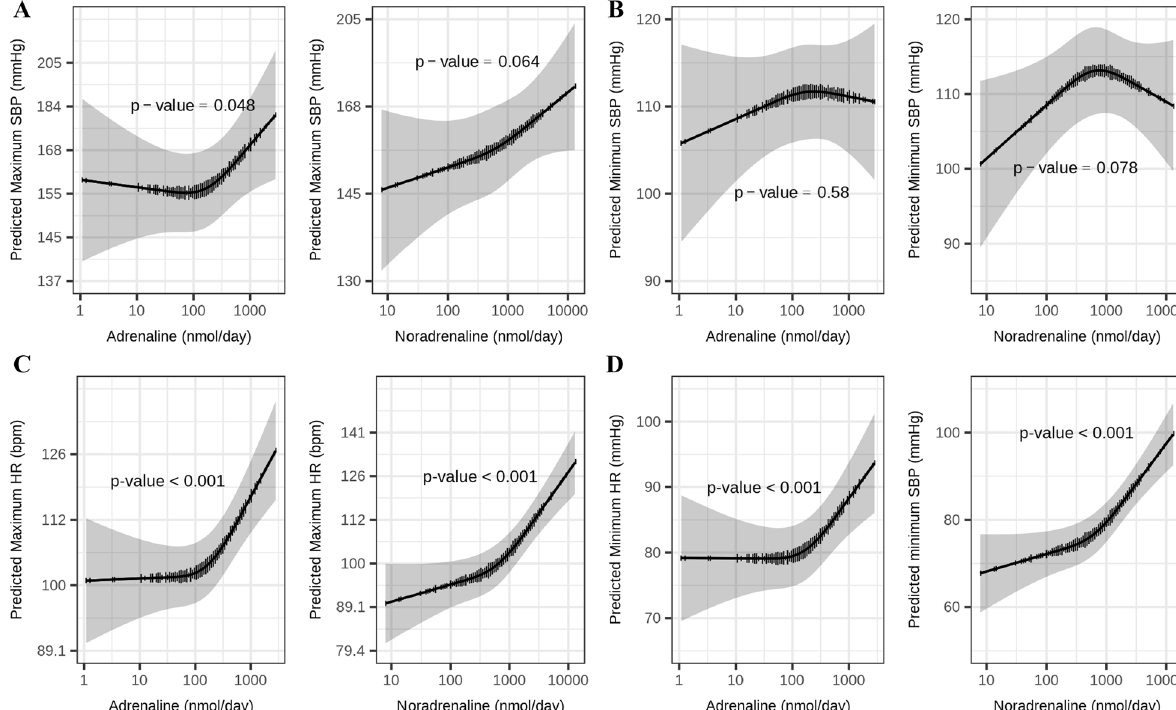
Fig. 1. 24-h urinary catecholamine excretion (nmol/day) and cardiovascular parameters on the 5th day of treatment. A Maximum systolic blood pressure (SBP), B minimum systolic blood pressure, C maximum heart rate (HR), and D minimum heart rate; mmHg millimeter of mercury, bpm beats per minute. The vertical lines represent the frequency counts of outcome variables. P -values indicate evidence for overall relationships between catecholamines and cardiovascular parameters measured from models via restricted cubic splines. All predictions are shown for age 48 years, male sex, equine intramuscular treatment interventions, and total doses of benzodiazepines of 2300 mg/day